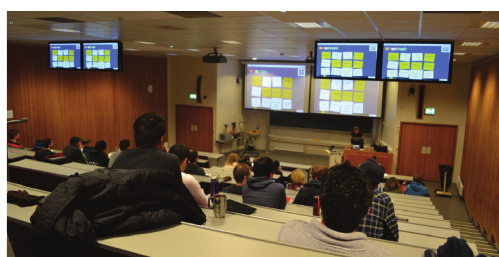
Figure 5: Using the Post-It application in lecture